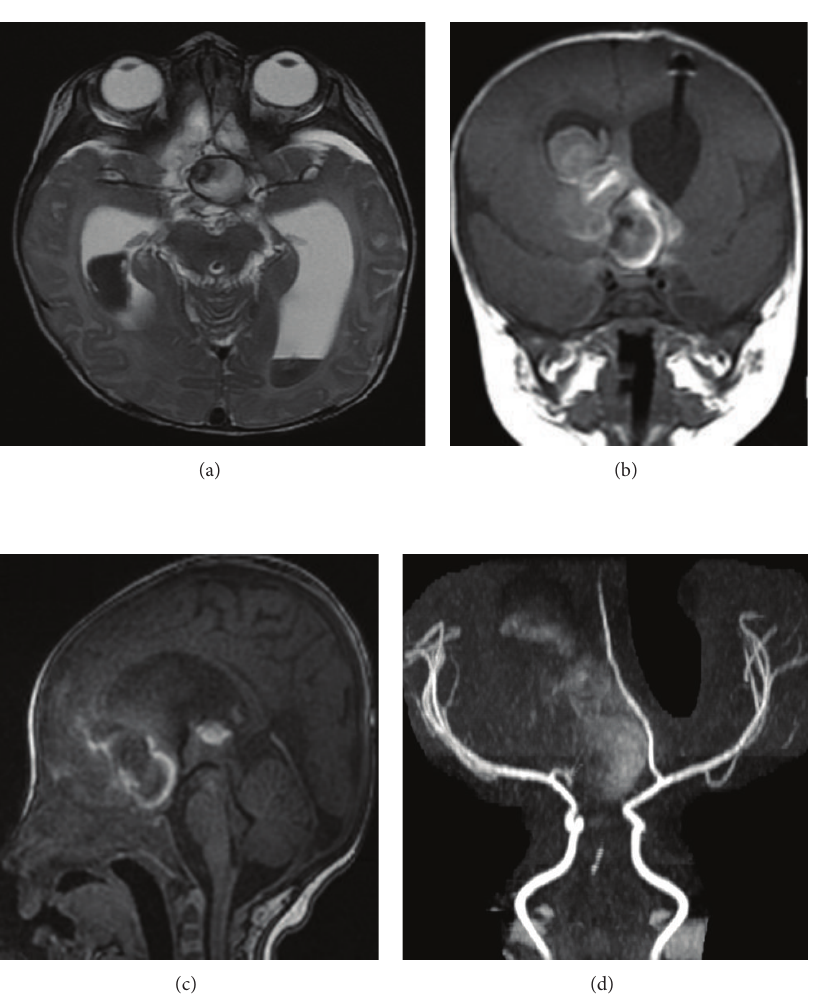
Figure 2: ((a), (b), and (c)) Early stage MRI demonstrating intraventricular hemorrhage with associated hydrocephalus and a large extra-axial suprasellar lesion measuring 26 mm diameter with a slight filling and an endoluminal thrombus; (d) on MRA no lesion is visualized, likely due to its partial thrombosis and sluggish blood flow. Only its repercussion on middle caliber vessels can be appreciated: left A1 segment of the anterior cerebral artery superiorly and laterally deviated and right A1 only visible on its proximal